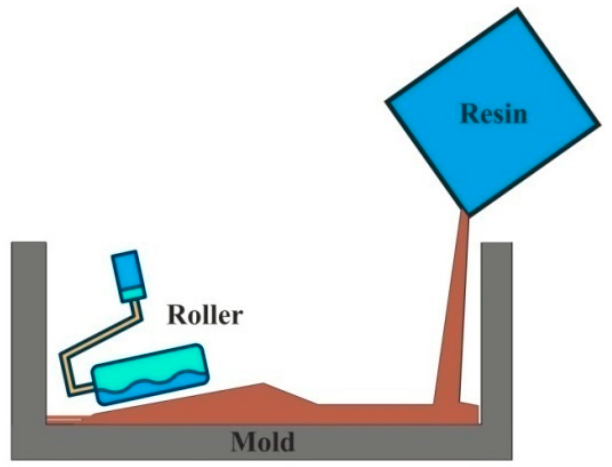
Figure 3. Hand layup process.